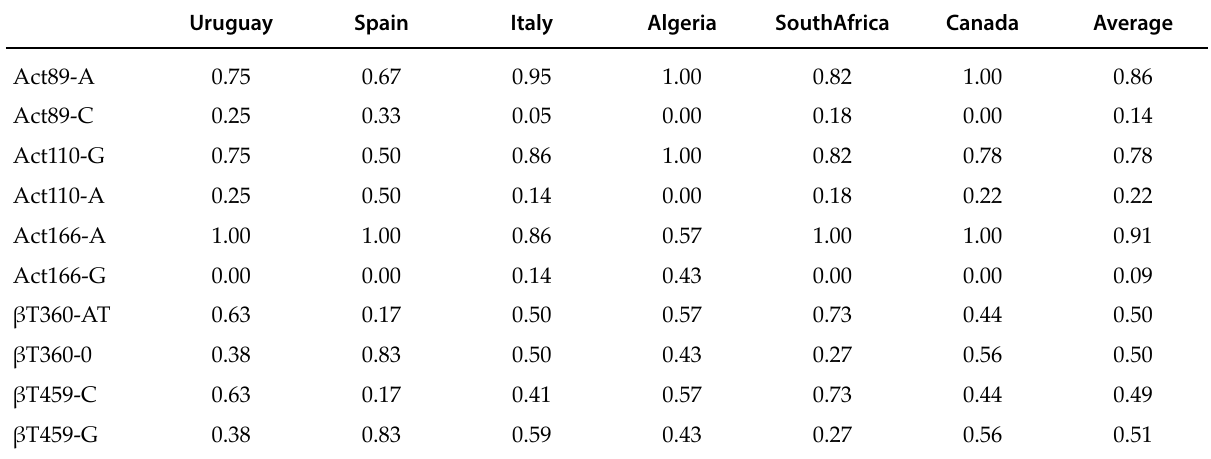
Table 2. Distribution of the allele frequencies across the Togninia minima samples from six countries. Uruguay Spain Italy Algeria SouthAfrica Canada